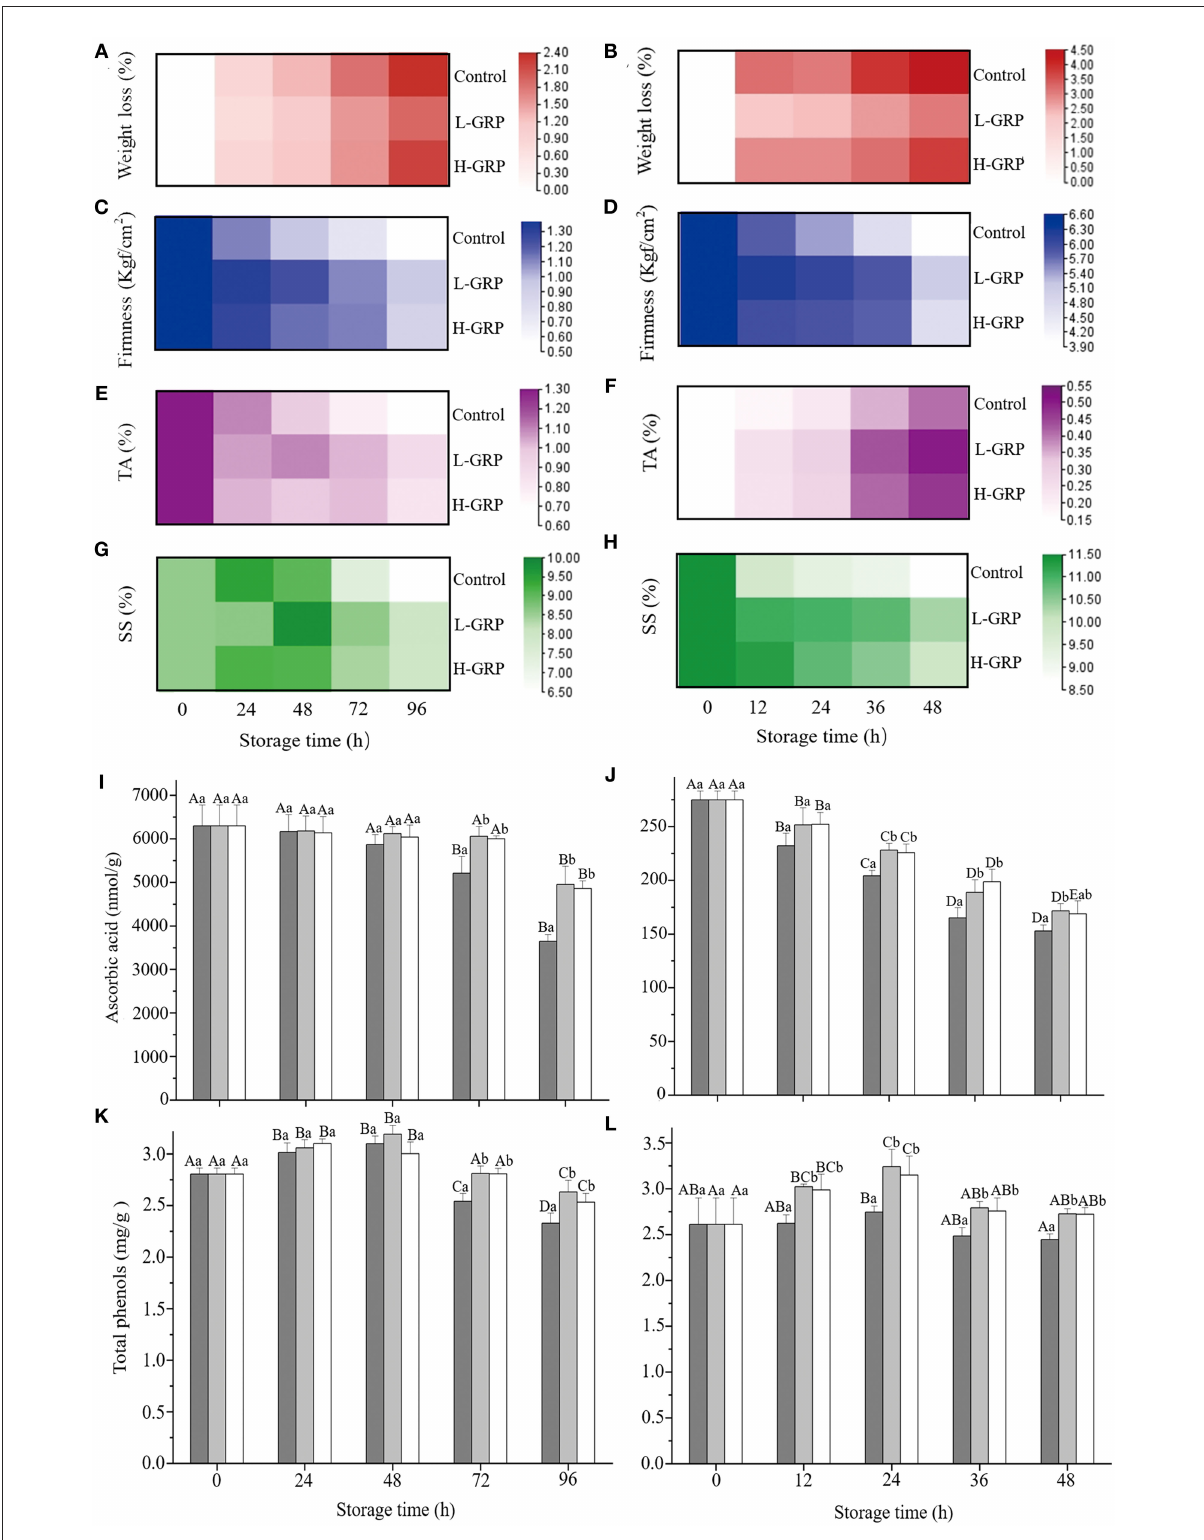
FIGURE4 Changes of weight loss (A,B) , firmness (C,D) , titratable acidity (E,F) , soluble solids (G,H) , ascorbic acid (I,J) , and total phenols (K,L) in strawberry (A,C,E,G,I,K) and fresh-cut apple (B,D,F,H,J,L) respectively, during storage at 20 ± 1 ◦ C and a relative humidity of 25 ± 2 % after treatments